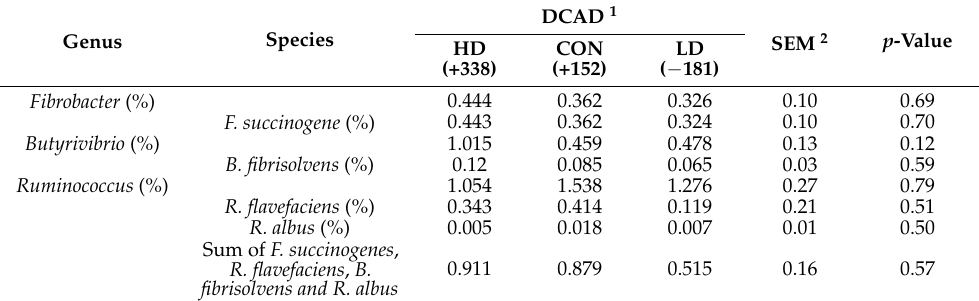
Table 3. Effect of varying dietary cation-anion difference on the relative abundance (%) of rumen cellulolytic bacteria communities of female goats.